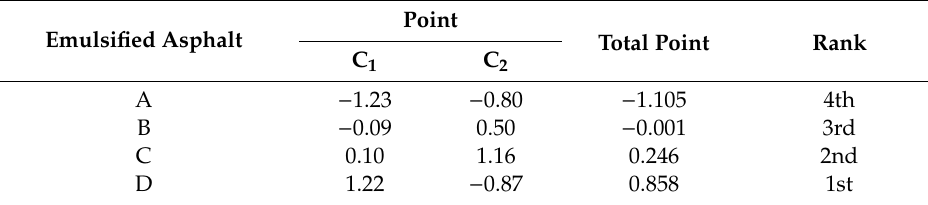
Table 9. Points of the principle